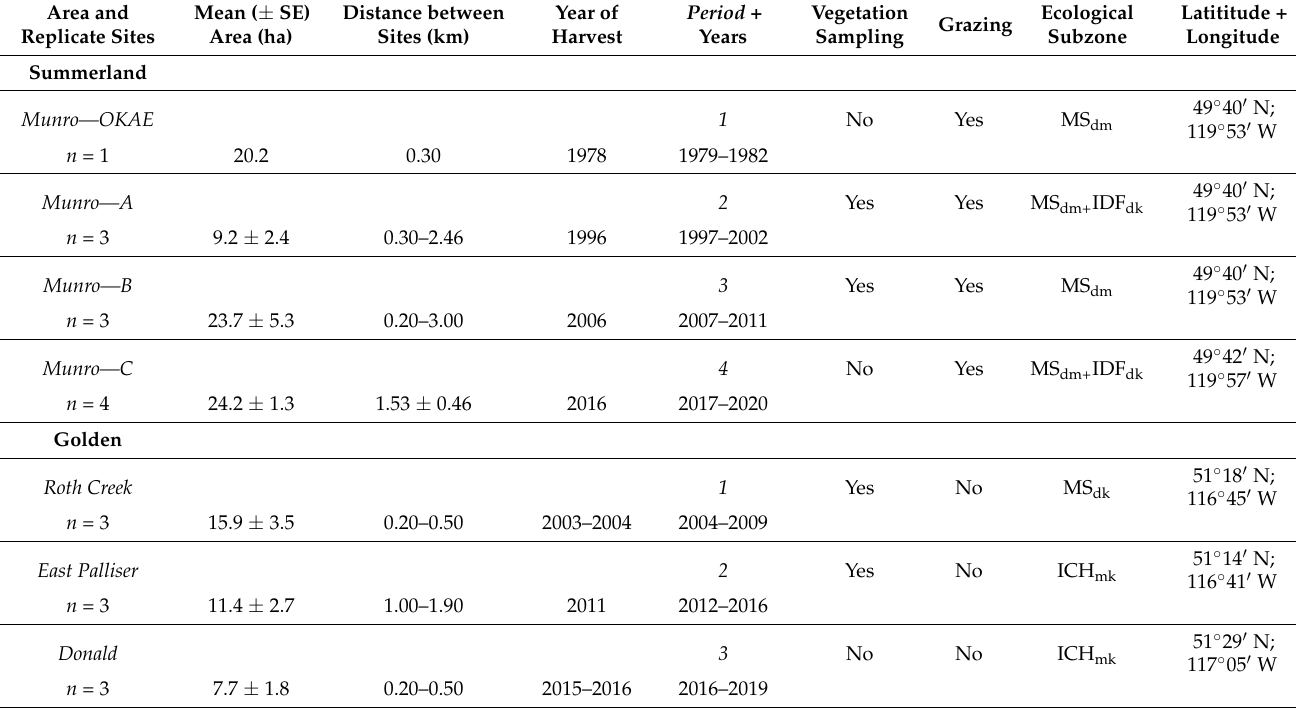
Table 1. Characteristics of Summerland and Golden study areas and treatment sites for the cumulative clearcutting study (LTCC) and grazed vs. ungrazed clearcutting (CC-GR)